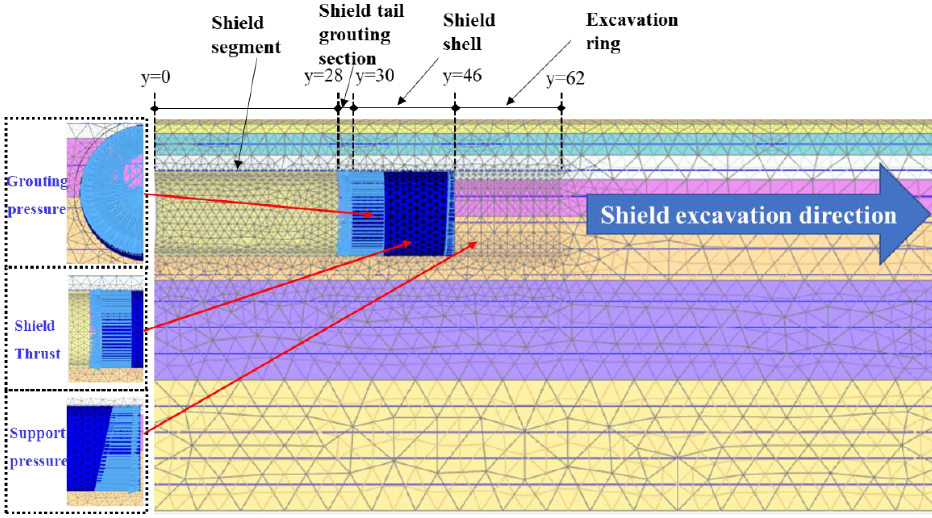
Figure 6. Three-dimensional finite element analysis model of the tunnel.